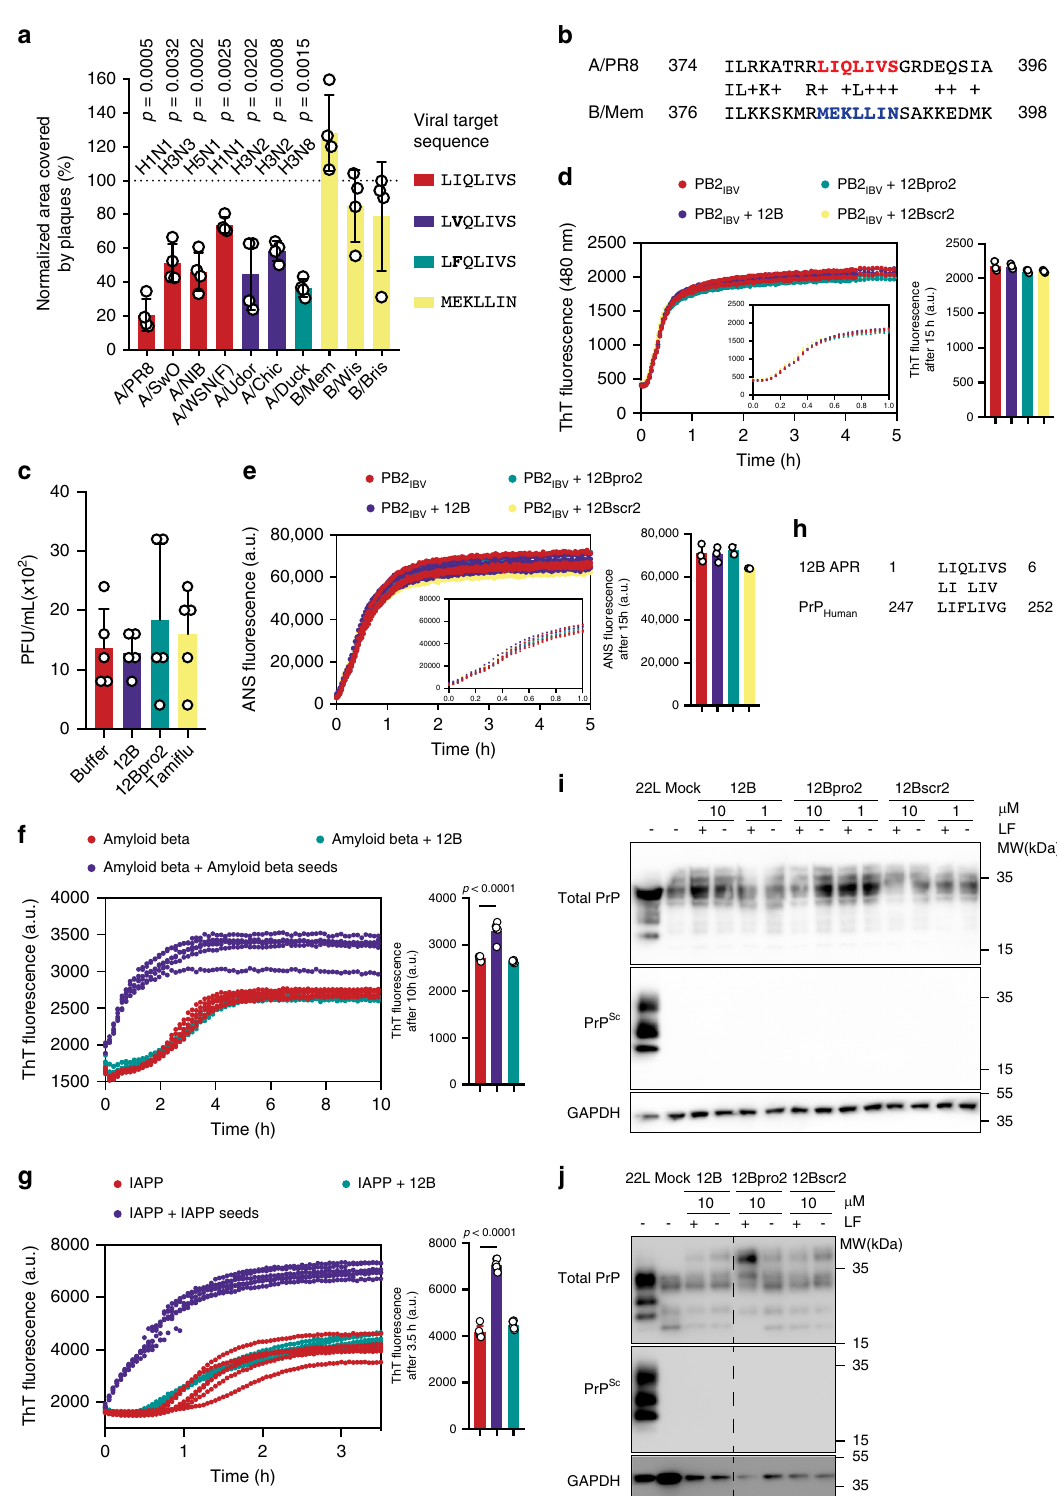
aggregation-prone amyloids when they share no similarity with viral entry (Supplementary Fig. 5a, b). In fl uenza B replication is peptide 12B (A β 42 or amylin (IAPP), Fig. 5f, g, respectively). To also not affected by peptide 12B in the murine infection model, explore the limits of the sequence-identity tolerance, we searched con fi rming the APR-speci fi c activity in vivo (Fig. 5c). As expected for a naturally occurring aggregation-prone protein with imperfect from the lack of target APR in the protein, peptide 12B showed no identity to peptide 12B. The C-terminal domain (glycosylpho- effect on the aggregation or conformational stability of recombi- sphatidylinositol-anchor sequence) of the prion protein (PrP) nantly puri fi ed PB2 CB from in fl uenza B/Mem (PB2 IBV ) as seen contains a region with high sequence homology to peptide 12B, from Th-T and ANS binding assays (Fig. 5d, e). In the same line, both in human and mouse, covering only two mismatches (Q249F peptide 12B was not able to affect the aggregation of the highly NATURE COMMUNICATIONS| (2020) 11:2832